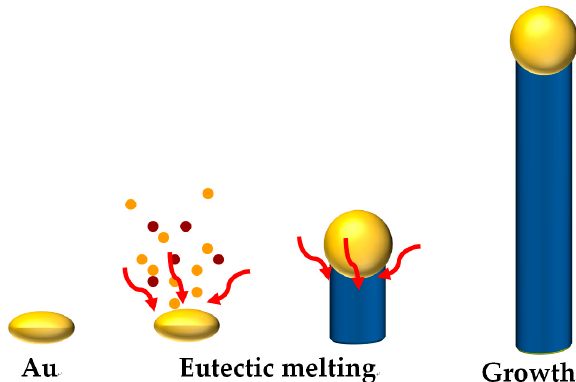
Figure 1. Schematic illustration of the vapor-liquid-solid mechanism.